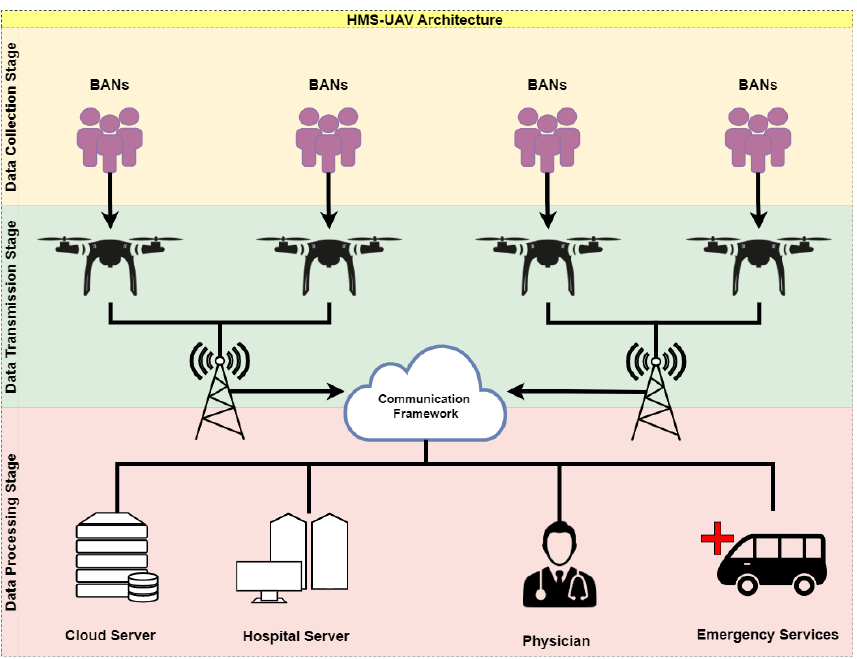
Figure 4. IoMT service